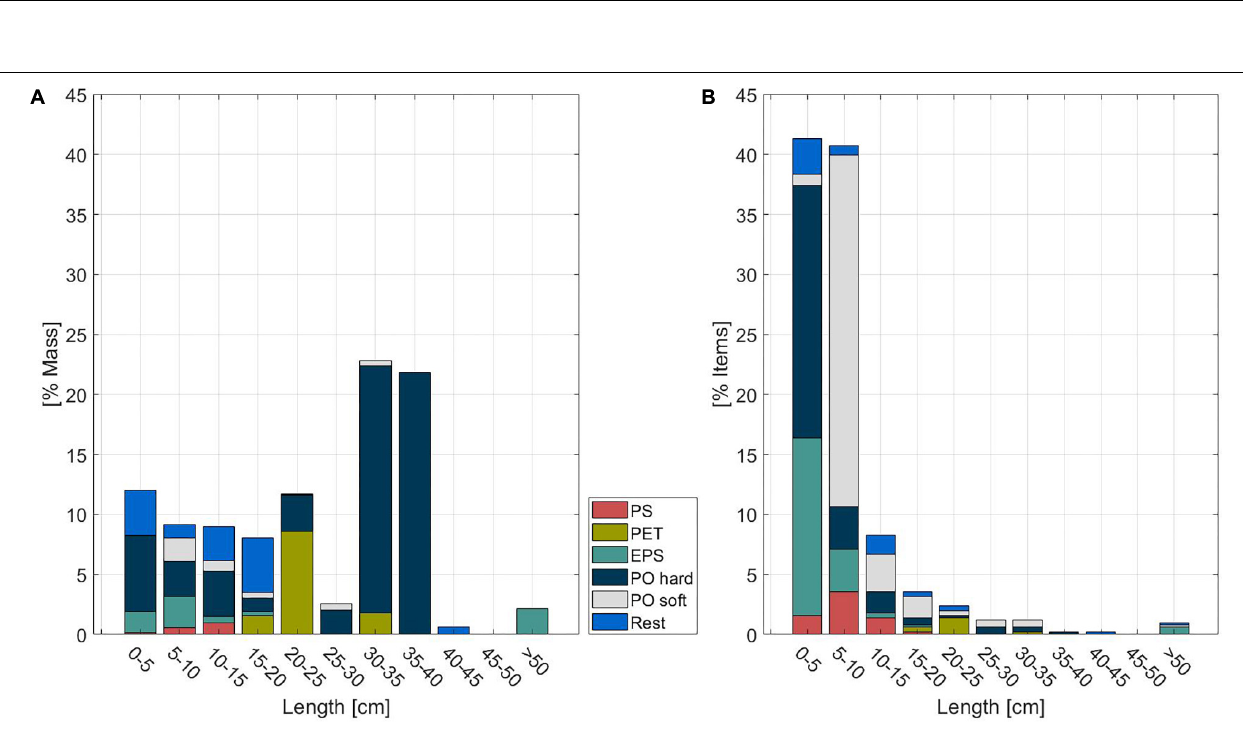
Frontiers in Marine Science |